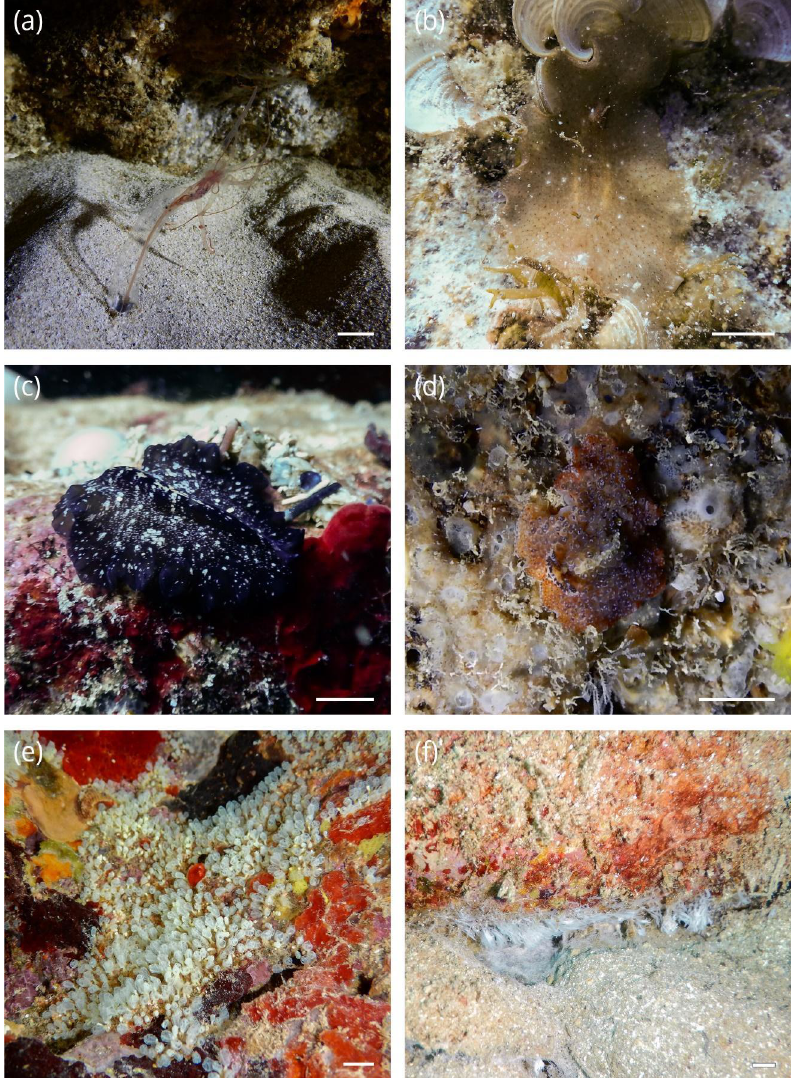
Figure 4. Photos of selected new records in the field. ( a ) Halcampoides purpureus on sand in Matrona Cave at 4 m; ( b ) Planocera ceratommata under a boulder on a rocky reef at 8 m; ( c ) Pseudoceros maximus-type A under a boulder on a rocky reef at 15 m; ( d ) Thysanozoon brocchii on a vertical wall in the Bortone’s cave at 8 m; ( e ) Pycnoclavella sp. at the entrance of Matrona Cave, 15 m; ( f ) colonies of Zoothamnium niveum at the edge between a rocky cliff and sand, 10 m. The scale bars correspond to 1 cm.